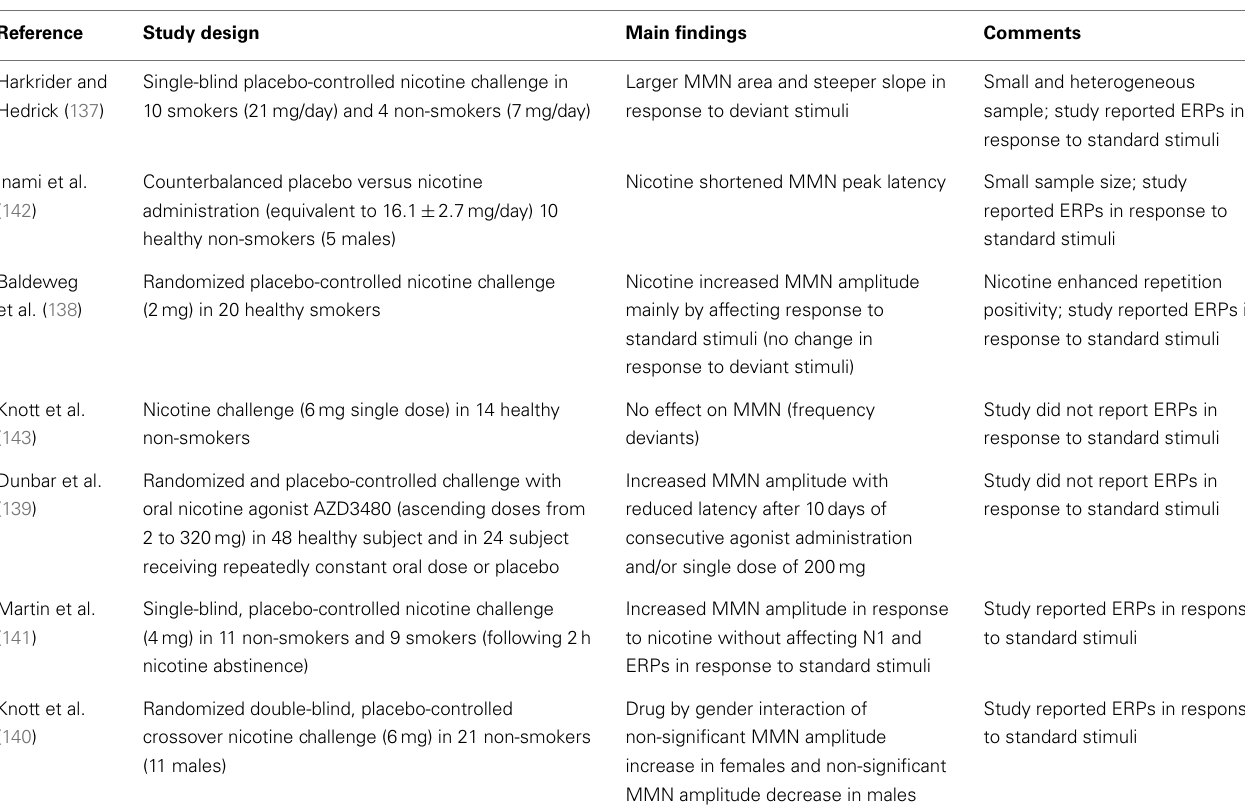
Table 2 | Nicotine receptor